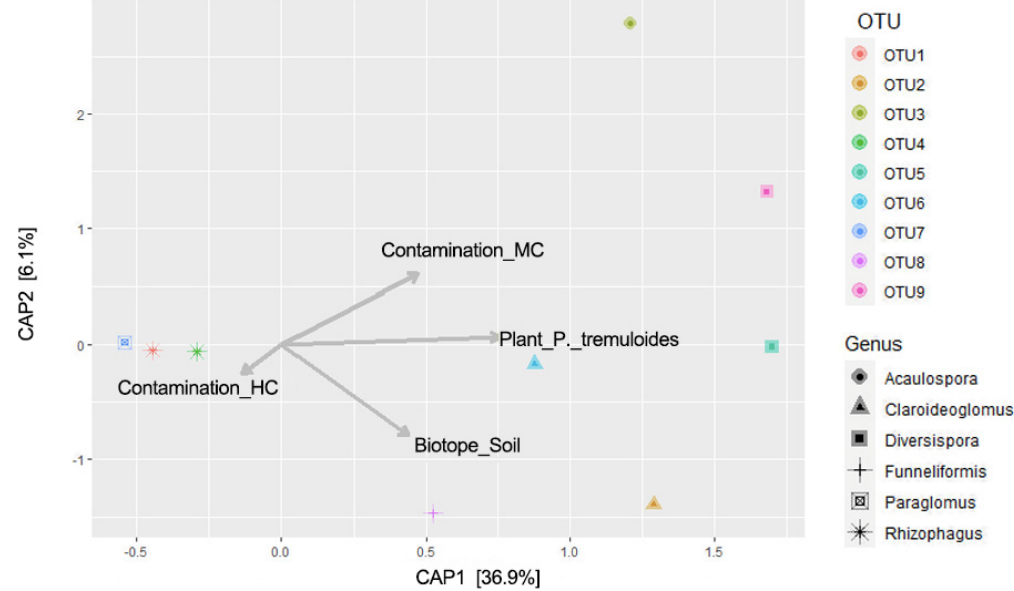
Figure 4. Distance-based redundancy analysis (db-RDA) summarizing the relationship between AMF OTU assemblages with three environmental factors: host plants species, contamination levels and biotopes. The identity of each OTUs were summarized in Supplementary Table S2. OTUs assigned to same genus have the same dot shape. A Monte Carlo permutation test with 1000 replicates was applied.